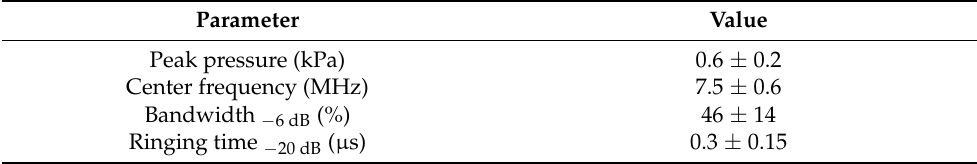
Figure 9. Time and frequency domain responses for all elements. ( a ) Envelope of the time signals. ( b ) Frequency spectrum. Table 2. Transmit performance of the prototype transducer.